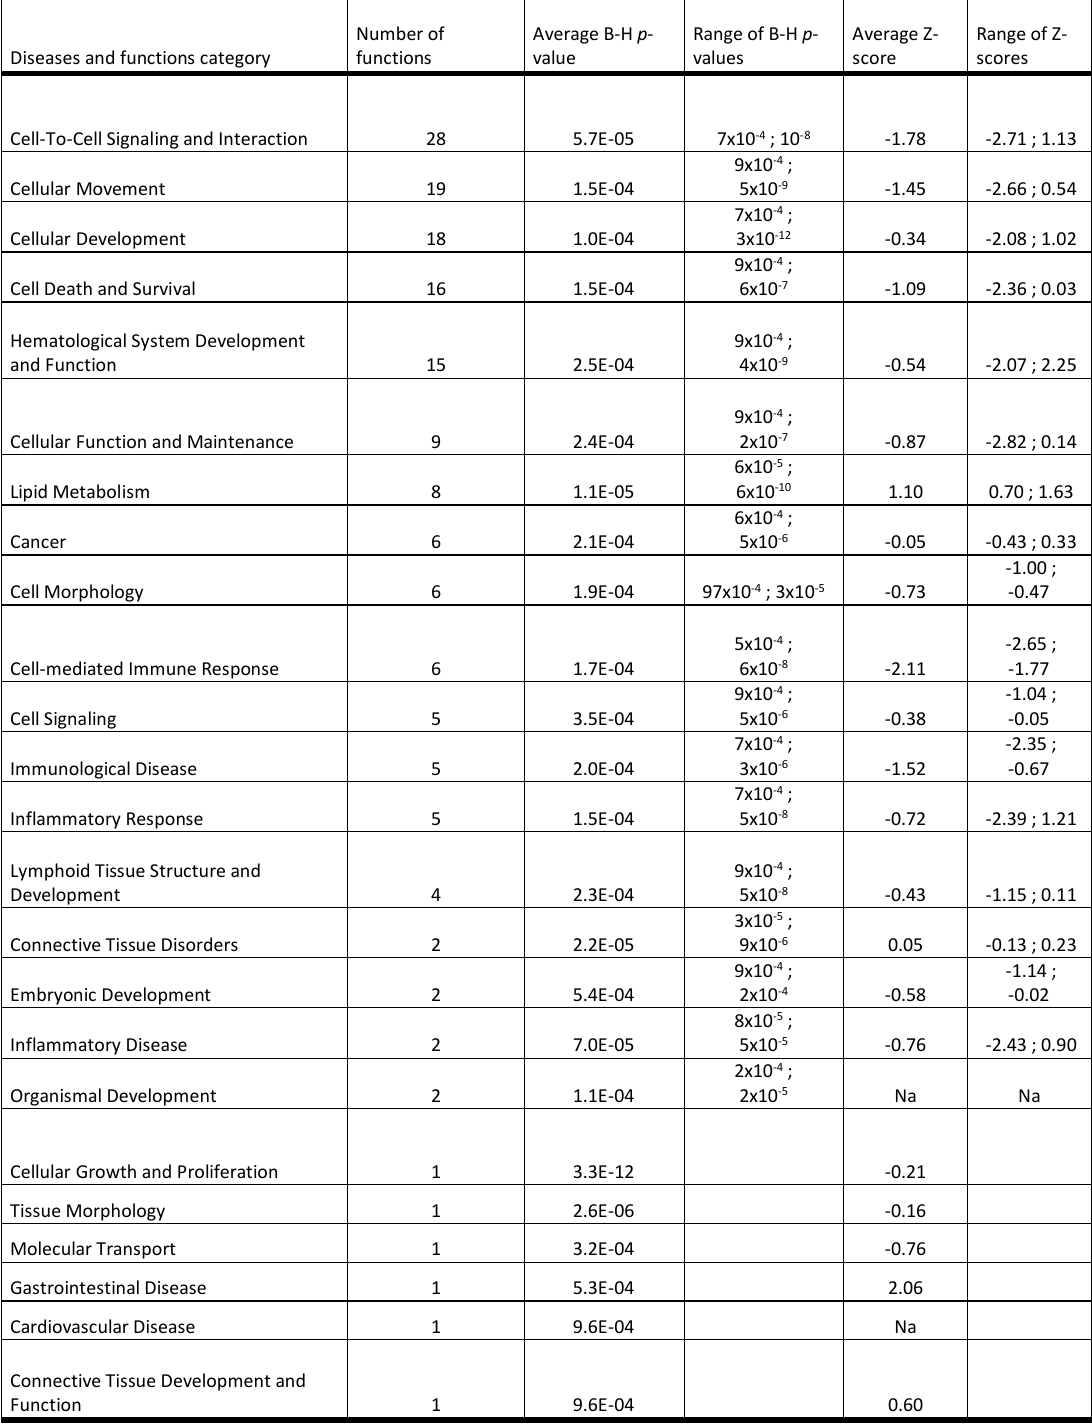
Table 1 - Diseases and functions categories enriched in the common DEGs in the within-breed contrasts. The name of diseases and functions categories was indicated, with for each category, the number of significant functions, their average B-H corrected p -value, the range of the B-H corrected p -values, the average Z-score, and its range. Na: not available